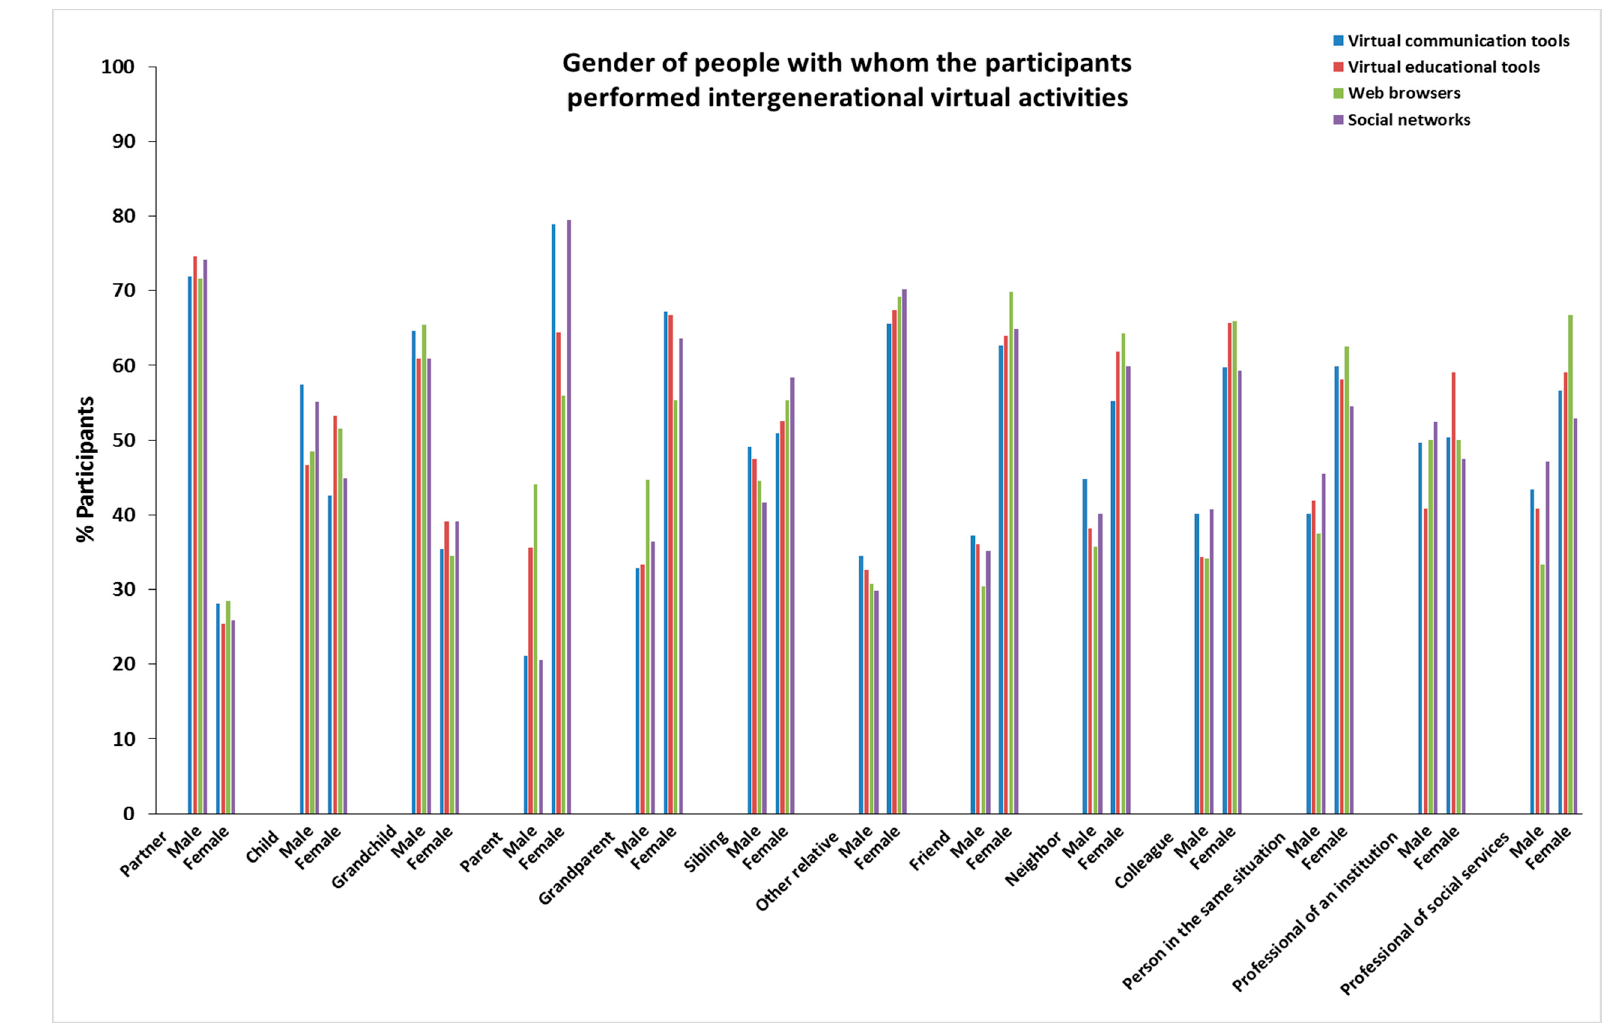
Figure 2. Sex of people with whom the participants performed intergenerational virtual activities.